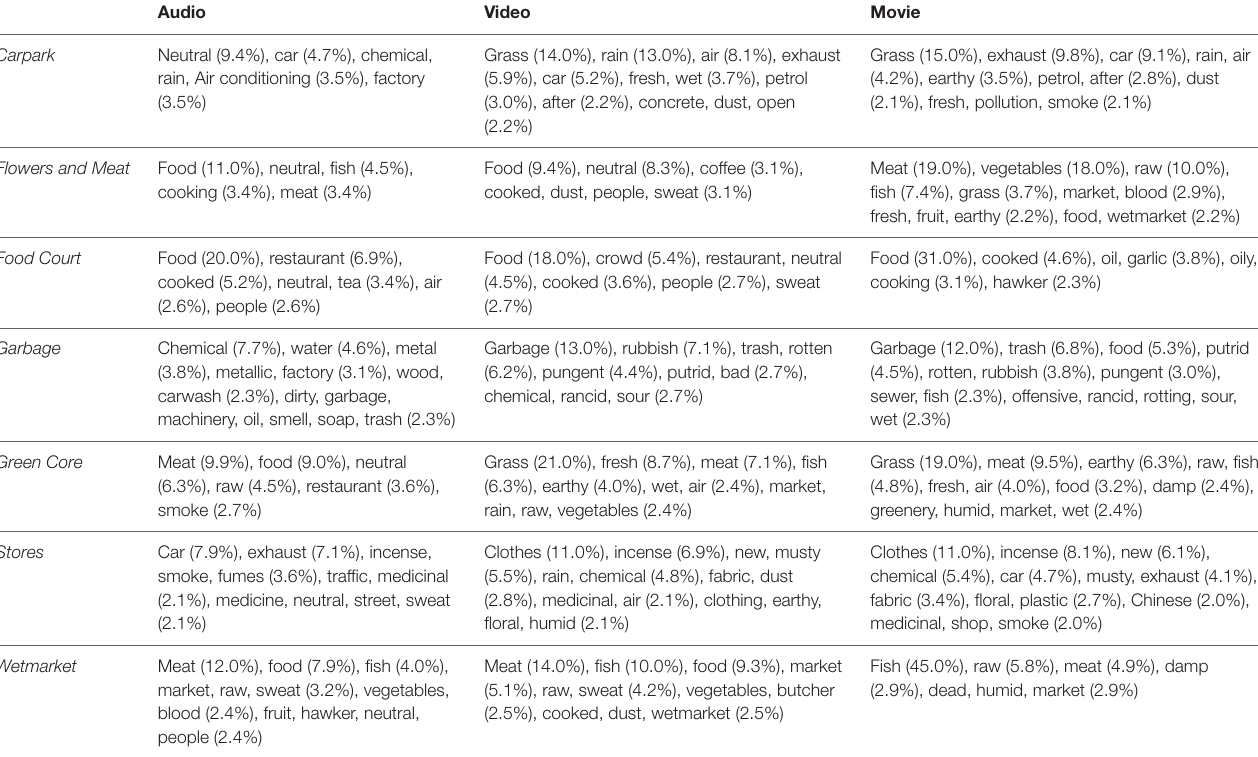
TABLE 2 | Most common descriptors for annotations of imagined smells ( N = 53) at seven locations in three modes of presentation.